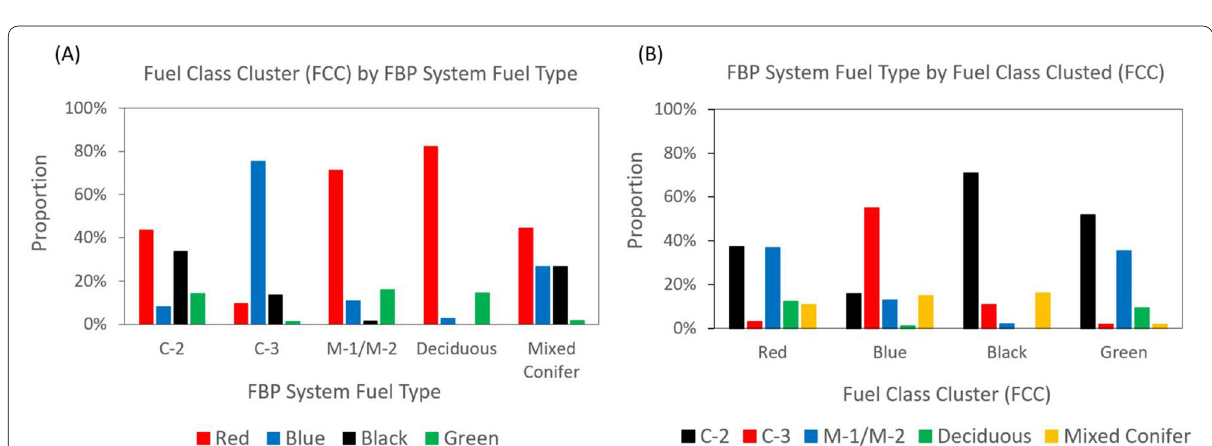
Fig. 5 A Distribution of fuel class clusters (FCCs) by Canadian Forest Fire Behaviour Prediction (FBP) System fuel type. B Distribution of FBP System fuel types by